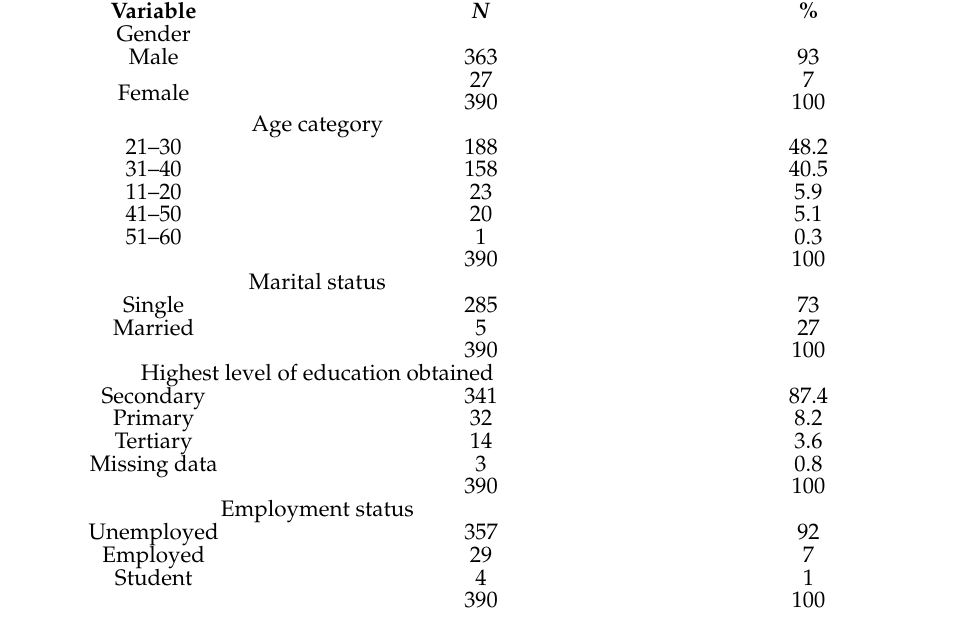
Table 2. Demographic profiling of the nyaope